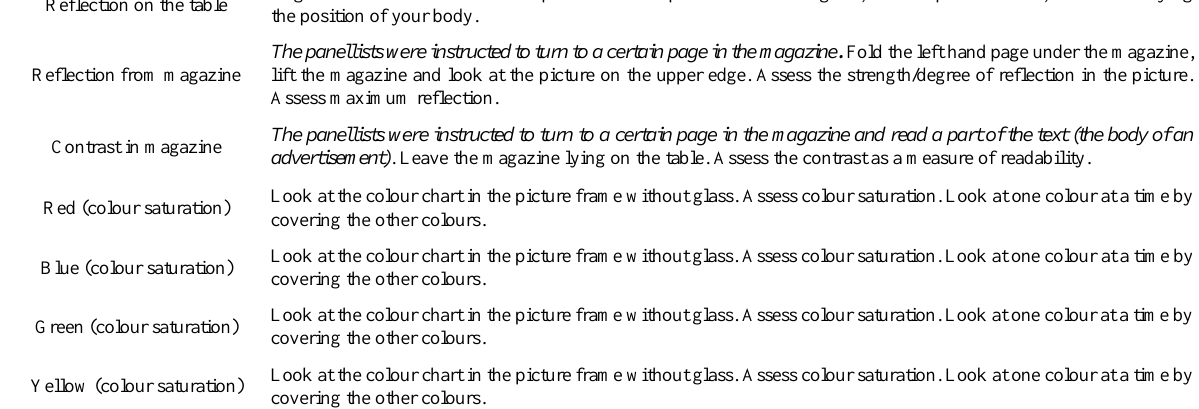
Table 1. Attributes and definitions used in the two assessments in sub-study 1 in 2016 (laboratory and real context) Attribute Definition Degree of glare – eye irritation. Look from the bottom to the top towards one of the booth corners (i.e. do not look Glare directly at the light source). Move your head and look straight at the corner. Flicker Degree of flicker. Look at the text that is posted on the wall where the wall and ceiling meet. Yellowness of the light Degree of yellowness. Look at the text that is posted on the wall where the wall and ceiling meet. source Light non-uniformity on the entire rear wall. Non-uniformity Little = completely even light distribution/gradient. To a great extent = shady and non-uniform/sharp transition between dark and bright areas. Sharpness of the shadow at the frame Sharpness of the frame’s shadow at the back edge Multiple shadows Reflection on the table Reflection from magazine Contrast in magazine